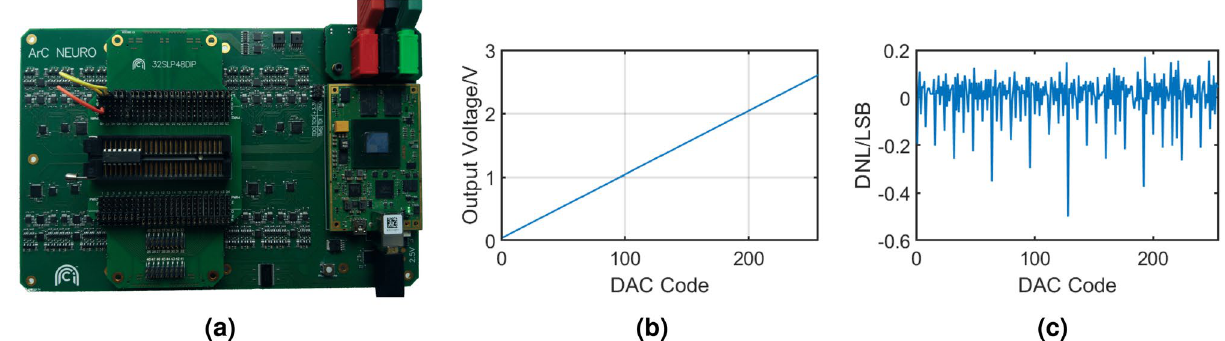
Figure 11. Results from an automated test of an AD558J DAC ( a ) in 2.56 V range. ( b ) shows the output from code 0 to code 255. ( c ) shows the normalised differential